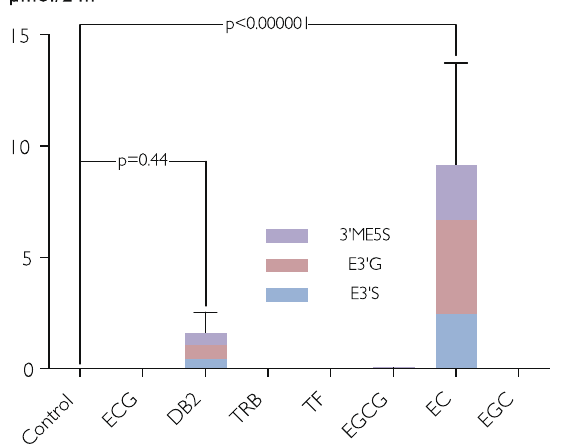
Figure 2. Urinary excretion of structurally related ( − )-epicatechin metabolites (SREM B ) following the consumption of different flavan-3-ols in male adults (n = 12). ECG, ( − )-epicatechin-3- O -gallate; DB2, procyanidin dimer B2; TRB: thearubigins; TF: theaflavins; EGCG, ( − )-epigallocatechin-3-O-gallate; EC, ( − )-epigallocatechin; EGC, ( − )-epigallocatechin. Differences in excretion were compared using a one-way ANOVA and a pair-wise comparison with Tukey’s Honest Significant Difference method 17 .